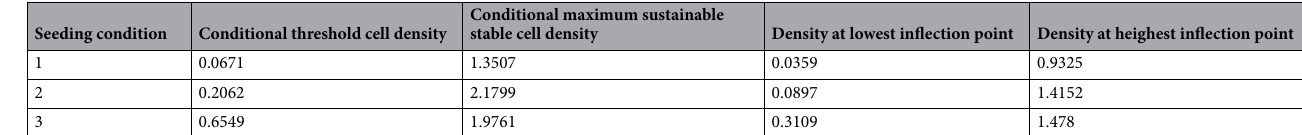
Table 3. Calculated cell densities from estimated parameters from our model